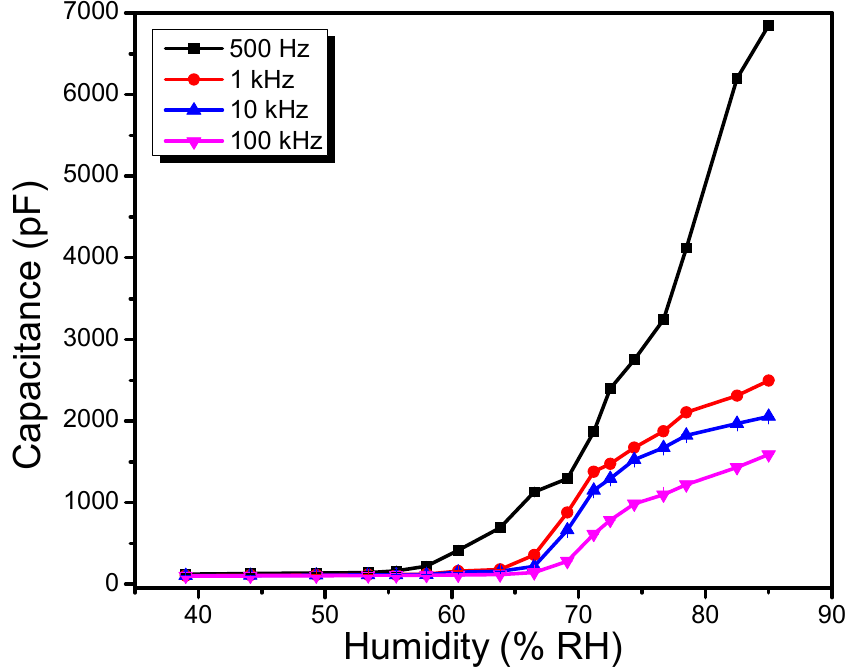
Figure 8. Effect of test frequencies on capacitance vs. %RH characteristics of Al/TPPNi/Al humidity sensor (error bar is too small to be visible on linear scale).